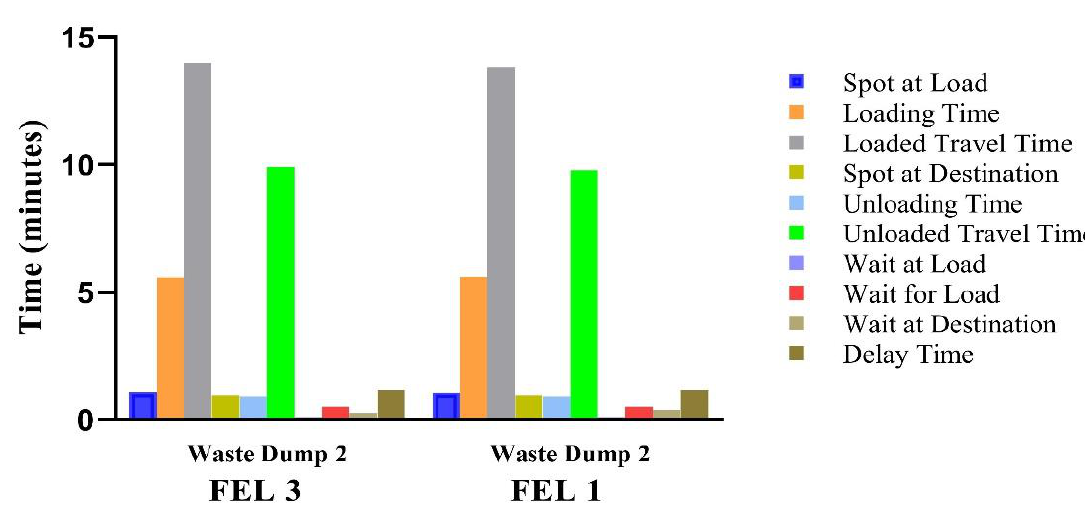
Figure 8. Total cycle time for trucks assigned to FELs.